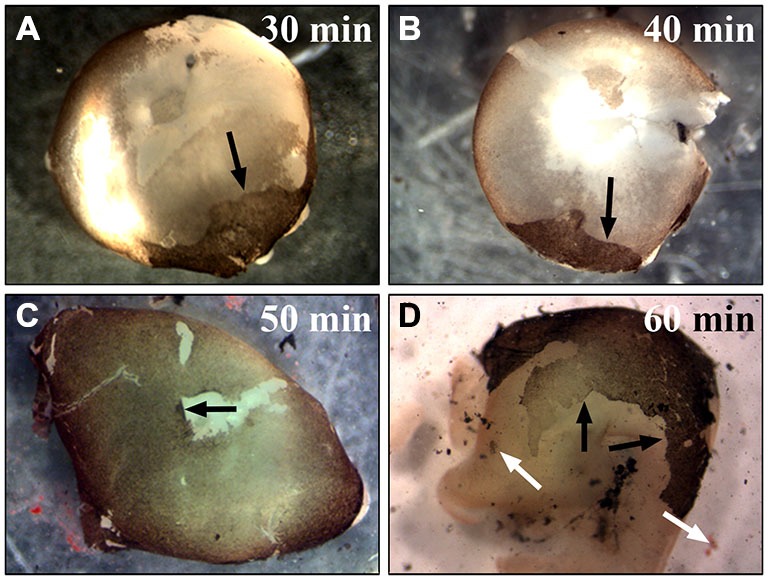
Incubation of the whole eye in papain for different times. To establish the best time point for the most efficient RPE isolation using papain the whole eye was incubated in papain solution (20 U/ml) for 30–60 min and longer. (A) After half an hour in papain, most RPE cells were still attached to the Bruch’s membrane, and with the removal of the retina only a small portion of the cells was removed from the eye (see arrow). (B) Digesting the eye for 40 min also only isolated a small number of RPE cells (see arrow). (C) The digestion of the whole eye for 50 min yielded the highest number of RPE cells (see arrow). (D) After 1 h or more the tissue started to get dissolved, and this resulted in a lower yield of RPE cells. The black arrows are pointing towards the attached RPE cell layer. The white arrows highlight the dissociated RPE tissue that was lost during the isolation.